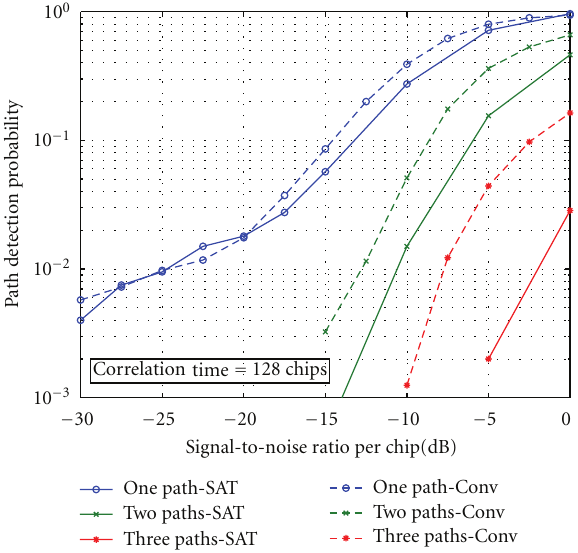
Figure 4: Probability of detection with 128 chips